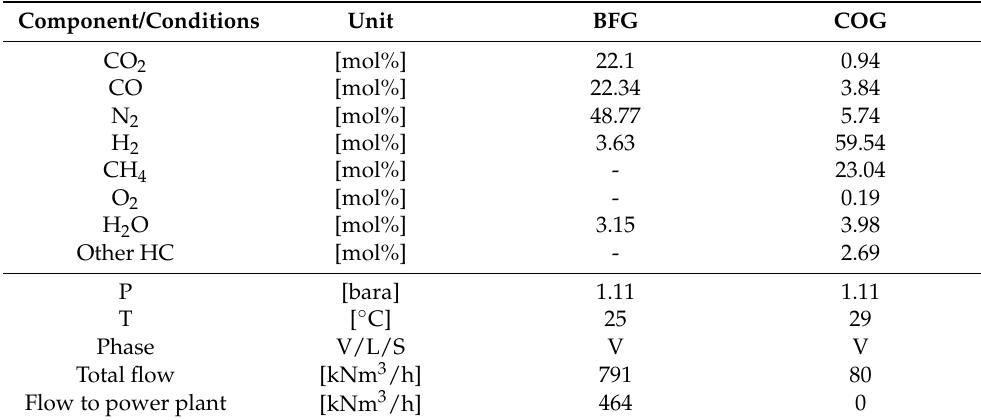
Table 2. BFG and COG composition and flow.